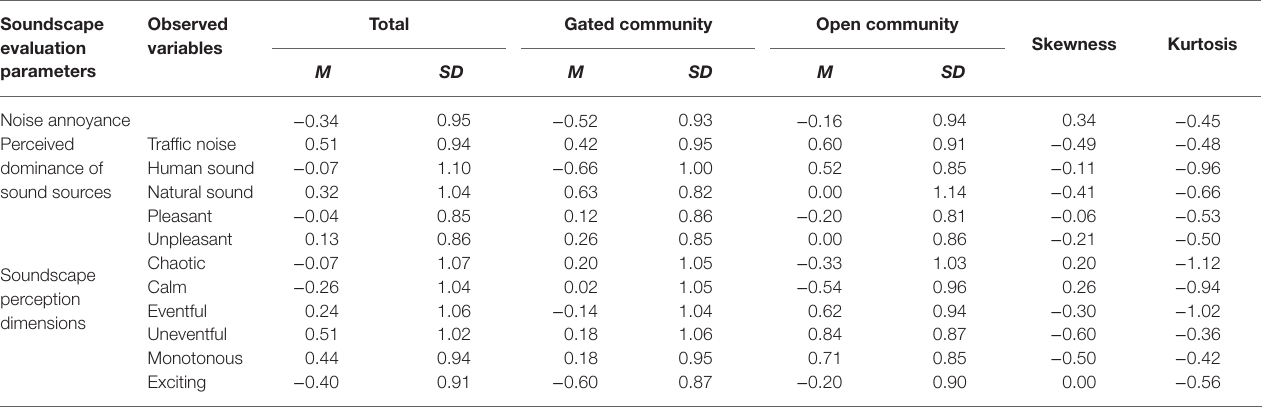
TABLE 2 | The descriptive statistics of the soundscape evaluation parameters.